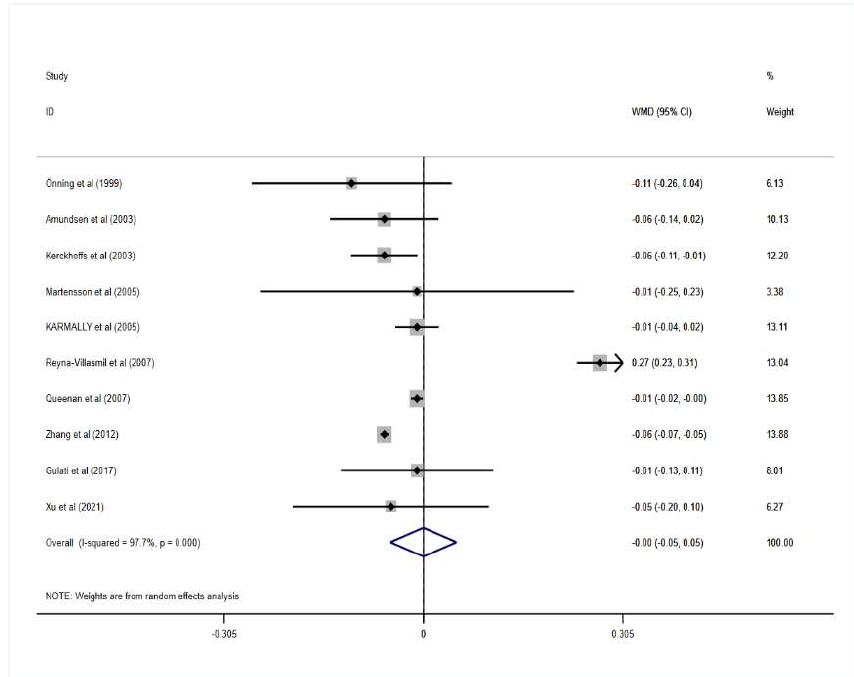
Figure 4. Effect of oat β-glucan on high-density lipoprotein-cholesterol (mmol/L) in patients with hyperlipidemia. Open diamonds: synthesis of summary results of all studies; Filled diamonds: point estimates for effect of each study; Grey squares: the weight of each study, the value of weigh is proportional to the diamond size; WMD: weighted mean difference. Arrow: effect size whose 95% confidence interval beyond the range of graphic display [18–30].